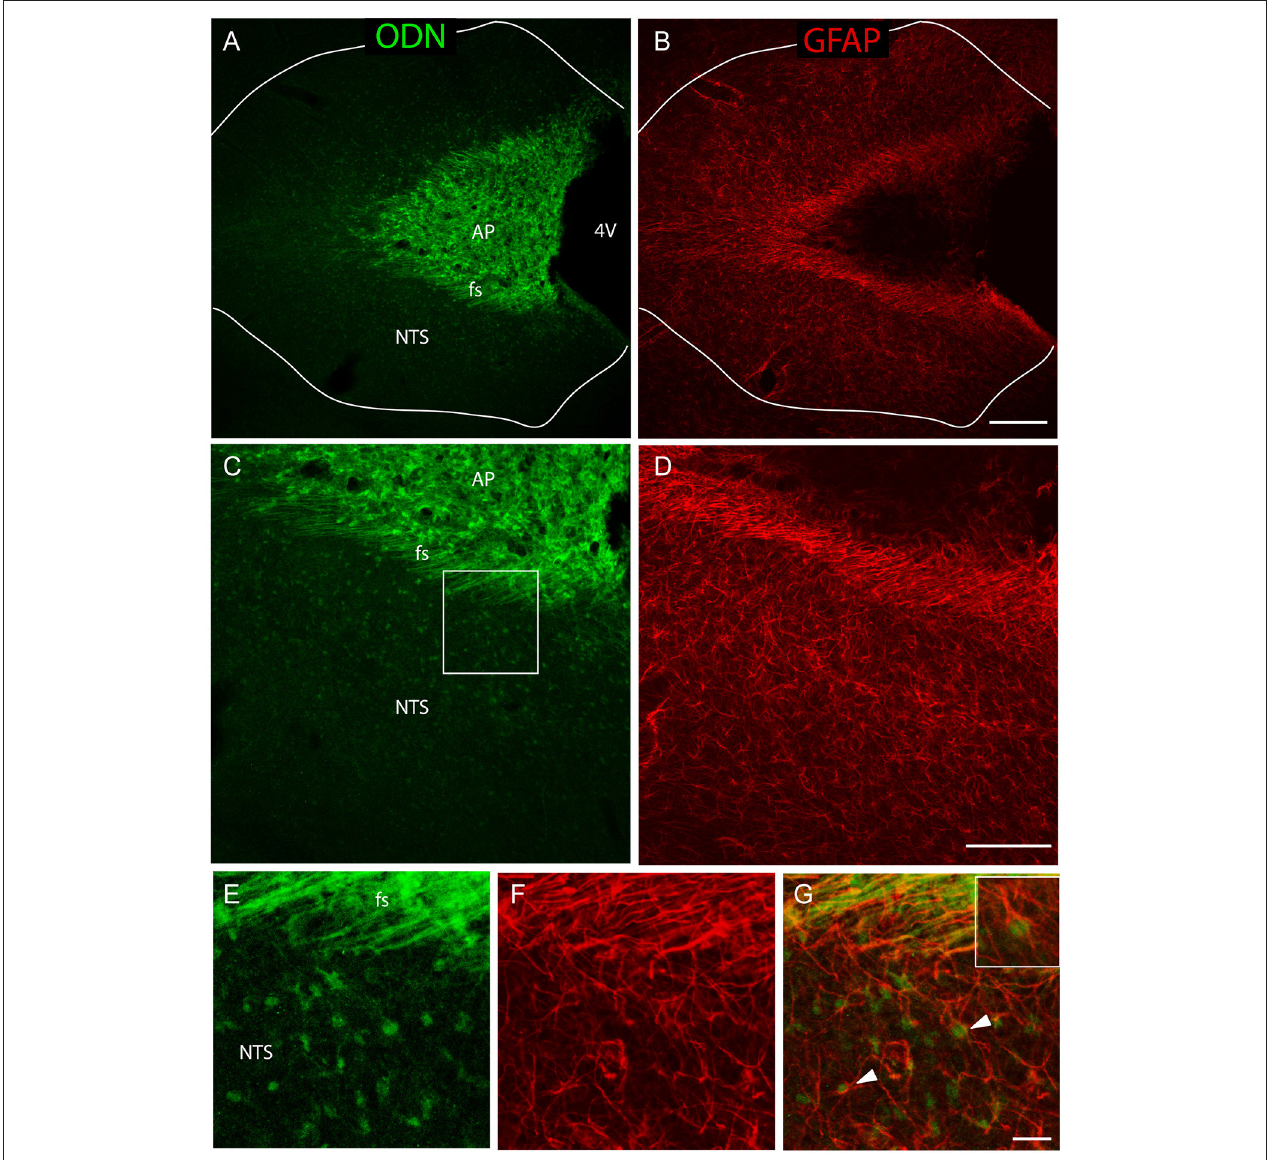
FIGURE 3 | A sub-population of NTS protoplasmic astrocytes expressed ODN. (A–D) Low-magnifications images illustrated the presence of a rounded ODN labeling within the NTS. This labeling was intense in the vicinity of the funiculus separens and progressively diminished in the lateral parts of the NTS (A–C) . Similarly, the distribution of GFAP labeling was heterogeneous within the NTS, with a lesser concentrated staining in the lateral part than in the areas surrounding the funiculus separens (B–D) . Lines in A and B symbolize the NTS boundaries. (E–G) High-magnification images illustrated the presence of ODN/GFAP double labeled protoplasmic astrocytes located within the subpostremal NTS bordering the AP (arrowheads in G ). Inset in G : Detail of an ODN positive astrocytes . Squares in (C,D) indicate the area from where images (E–G) originate. Scale bars: 250 µ m in (A–B) ; 100 µ m in (C–D) , 10 µ m in (E–G)